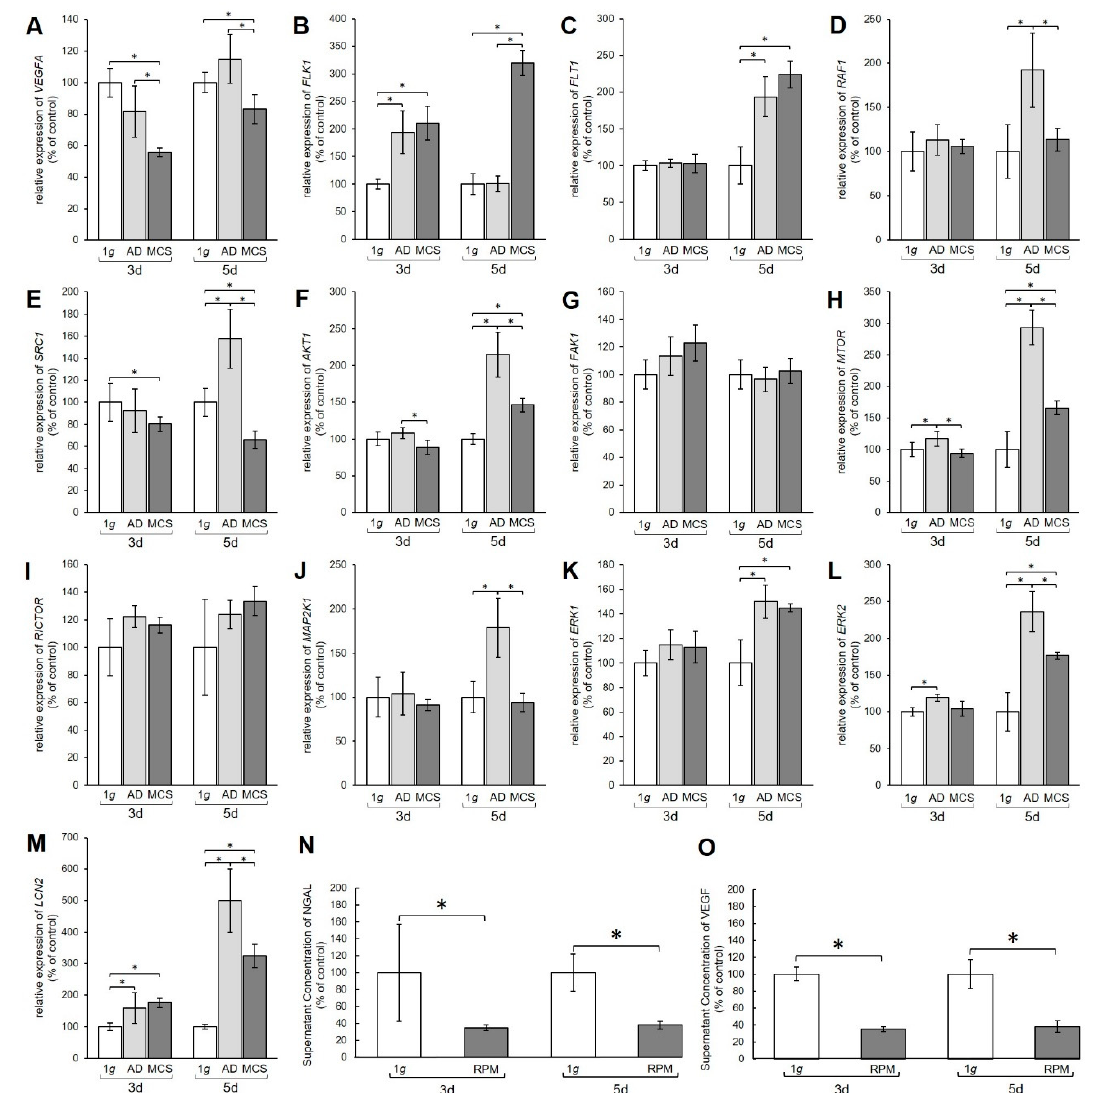
Figure 2. Gene expression of various proteins from the vascular endothelial growth factor (VEGF) signaling pathway. Results show relative mRNA transcription levels from ( A ) VEGFA , ( B ) FLK1 , ( C ) FLT1 , ( D ) RAF1 , ( E ) SRC1 , ( F ) AKT1 , ( G ) FAK1 , ( H ) MTOR , ( I ) RICTOR , ( J ) MAP2K1 , ( K ) ERK1 , ( L ) ERK2 , and ( M ) LCN2 genes. Results are shown as percentages of 3-day and 5-day 1 g controls. Time-resolved immunofluorometric assay (TRIFMA) results show amounts of ( N ) NGAL and ( O ) VEGF proteins in the supernatant taken from 3-day and 5-day flasks containing PC-3 cells, shown as percentages of 3-day and 5-day 1 g controls. * p < 0.05.